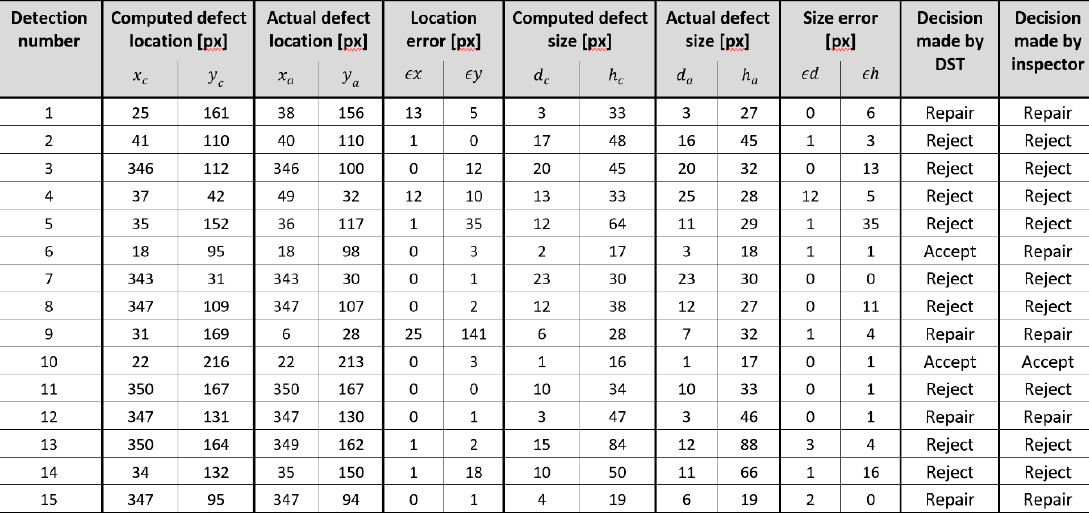
Figure A1. Result table with computed and actual defect characteristics and generated maintenance actions compared to actual action.